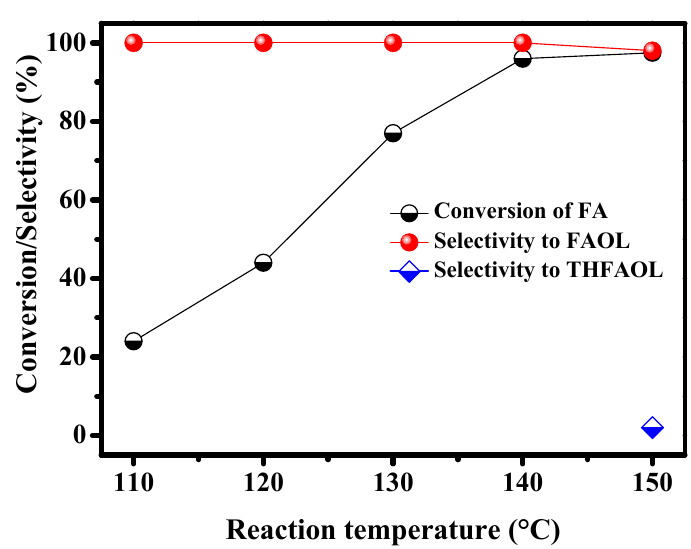
Figure 11. The effect of reaction temperature on the CTH of FA over 5CuHAp. Reaction Conditions: The catalyst weight (100 mg), 2-propanol (5 mL), FF (480 mg), reaction temperature—(110–150 °C) at 2 MPa N 2 pressure and reaction time—4 h.